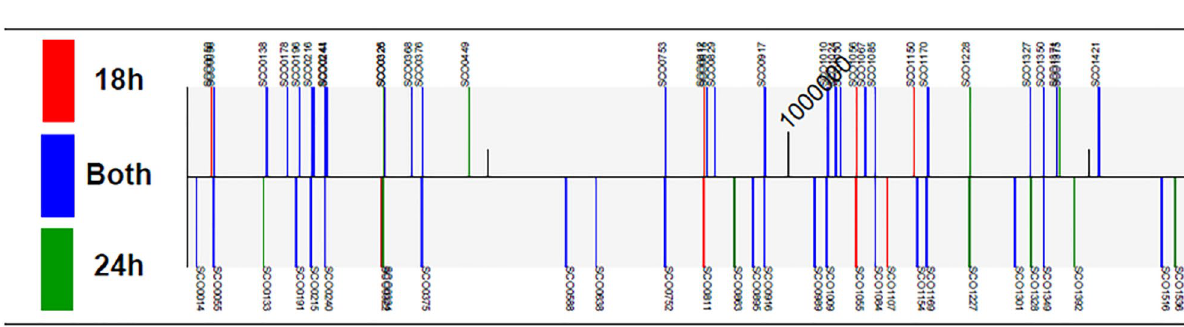
Figure 5. Plot of the methylated cytosines at 18 and 24 h of growth of the M145 strain in the MG